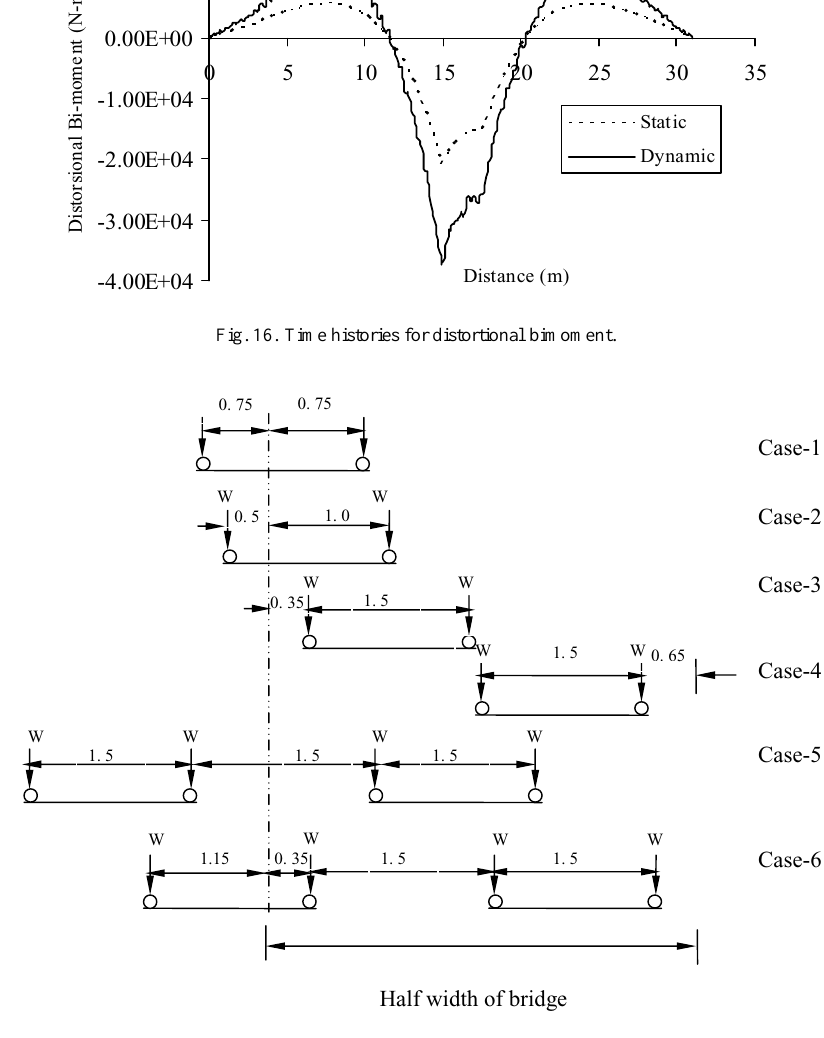
Fig. 17. Traverse loading cases on curved box girder